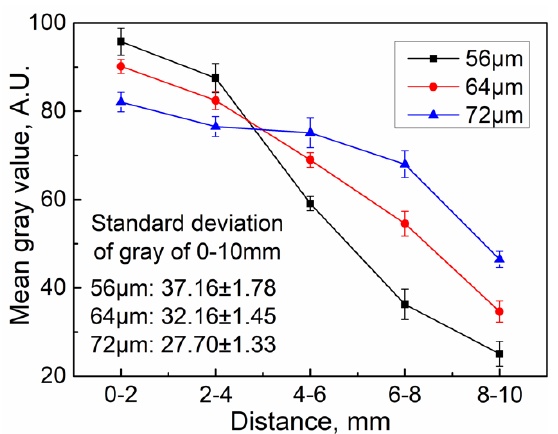
Figure 6. Influence of the ultrasonic amplitude on the trajectory of the fluorescent particles in numerical simulation (ultrasonic frequency, 20 kHz; the ultrasonic amplitudes are all peak-to-peak values of the sinusoidal wave. These are defined according to the allowable range of the ultrasonic vibration system used in the experiment for comparison): ( a ) particle seeding; ( b ) particle tracing.